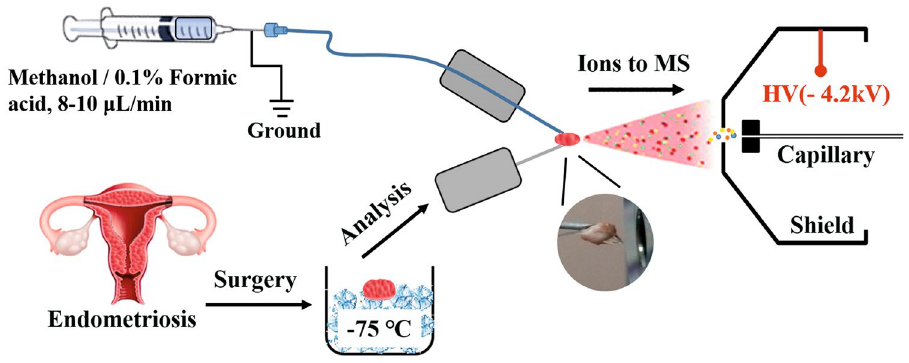
Figure 1. Flowchart of the experiment and schema of the direct tissue spray ion source.